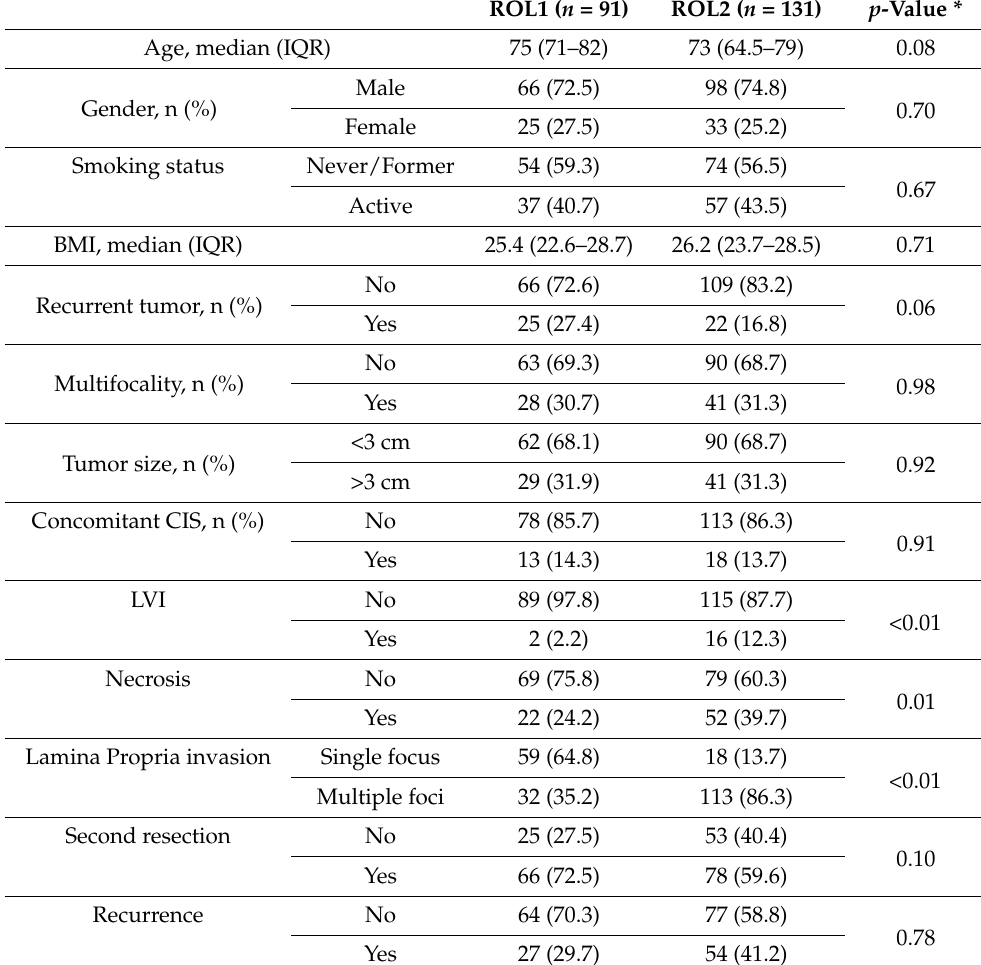
Table 2. Characteristics of patients stratified according to ROL